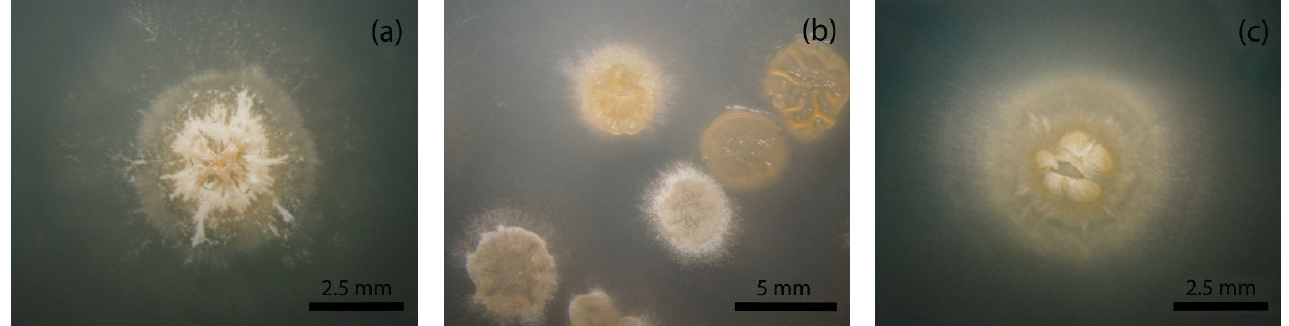
Figure 1. ( a ) Typical morphology of A. coloradensis growing on Medium V 0.1, ( b ) different mor- phologies observed on agar medium, and ( c ) high producer A. coloradensis C14 grown on Medium V 0.1